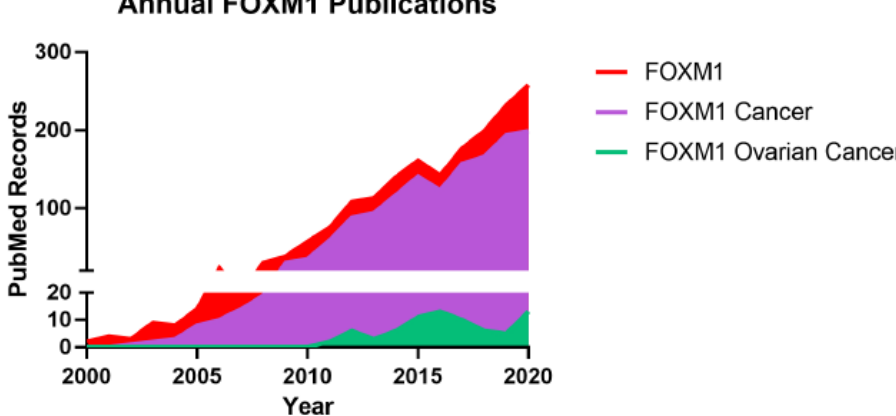
Figure 1. Annual FOXM1 Publications. The data shown were generated from PubMed searches conducted on 04/13/21. The search terms used (all fields) were “FOXM1” (results in red), “FOXM1 cancer” (results in purple), and “FOXM1 ovarian cancer” (results in green). The first “FOXM1 ovarian cancer” PubMed record is the TCGA HGSC study published in 2011 [30].